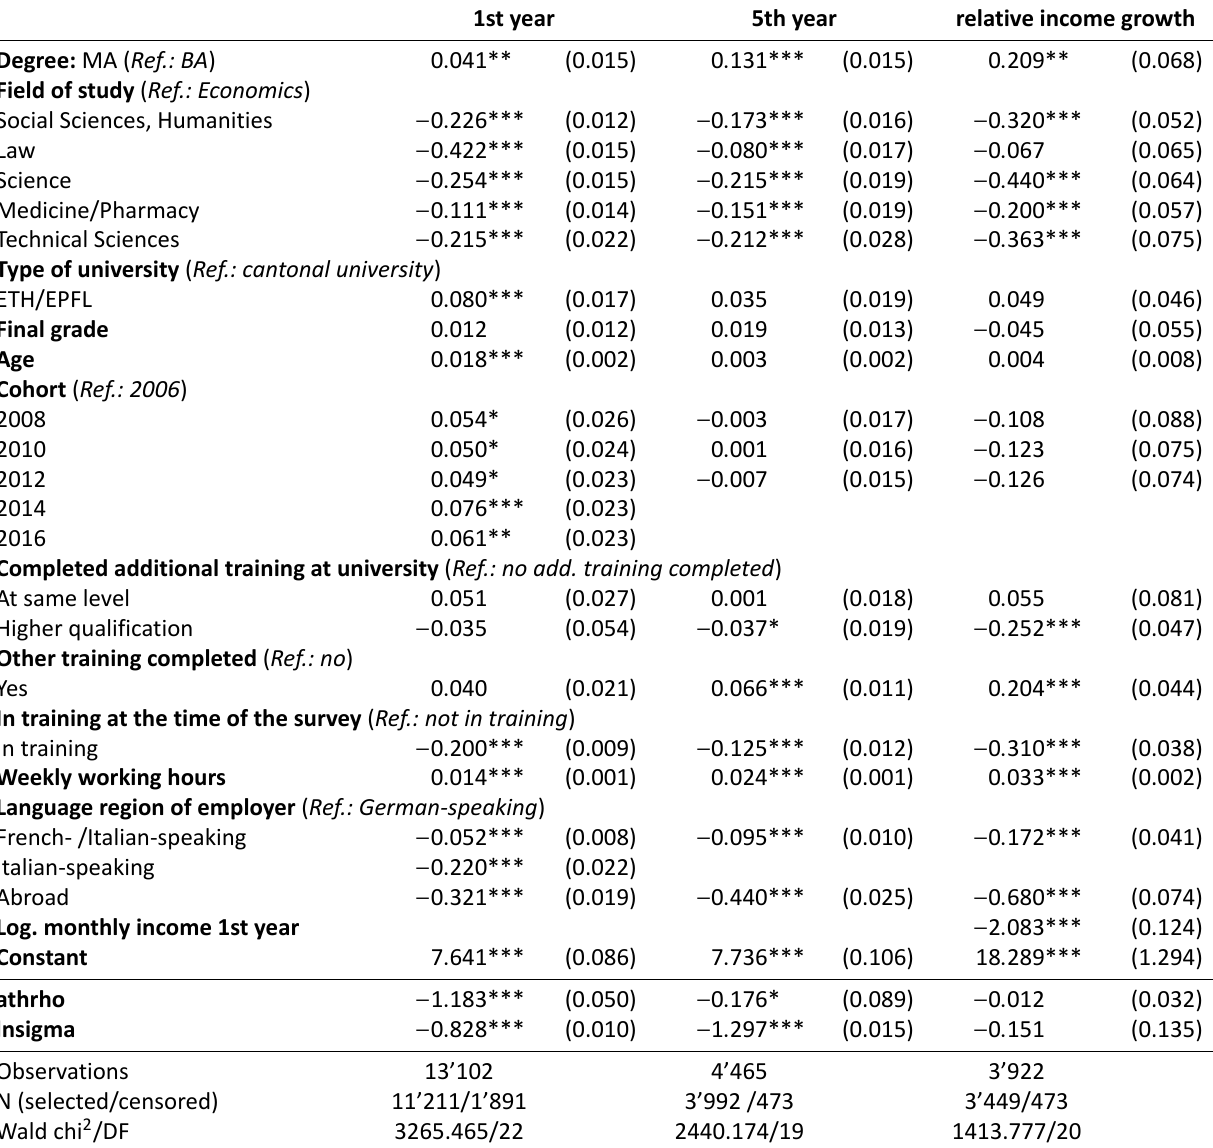
Table 2. Women’s monthly income (log.) in the first and fifth year after graduation and their relative income